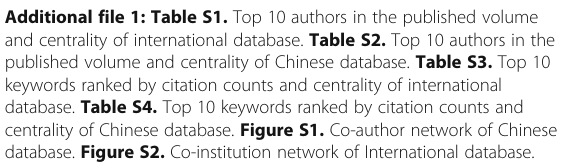
Additional file 1: Table S1. Top 10 authors in the published volume and centrality of international database. Table S2. Top 10 authors in the published volume and centrality of Chinese database. Table S3. Top 10 keywords ranked by citation counts and centrality of international database. Table S4. Top 10 keywords ranked by citation counts and centrality of Chinese database. Figure S1. Co-author network of Chinese database. Figure S2. Co-institution network of International